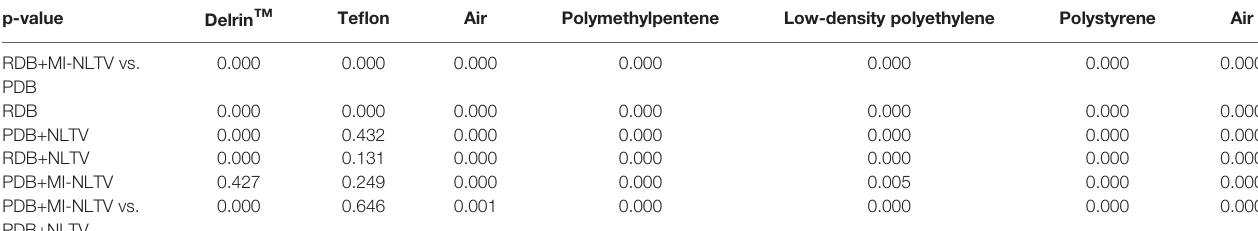
TABLE 2 | Statistical analysis comparing the CNR values of RDB+MI-NLTV vs. different combinations and PDB+MI-NLTV vs. PDB+NLTV for each type of insert using the paired t-test. p-value Delrin ™ Te fl on